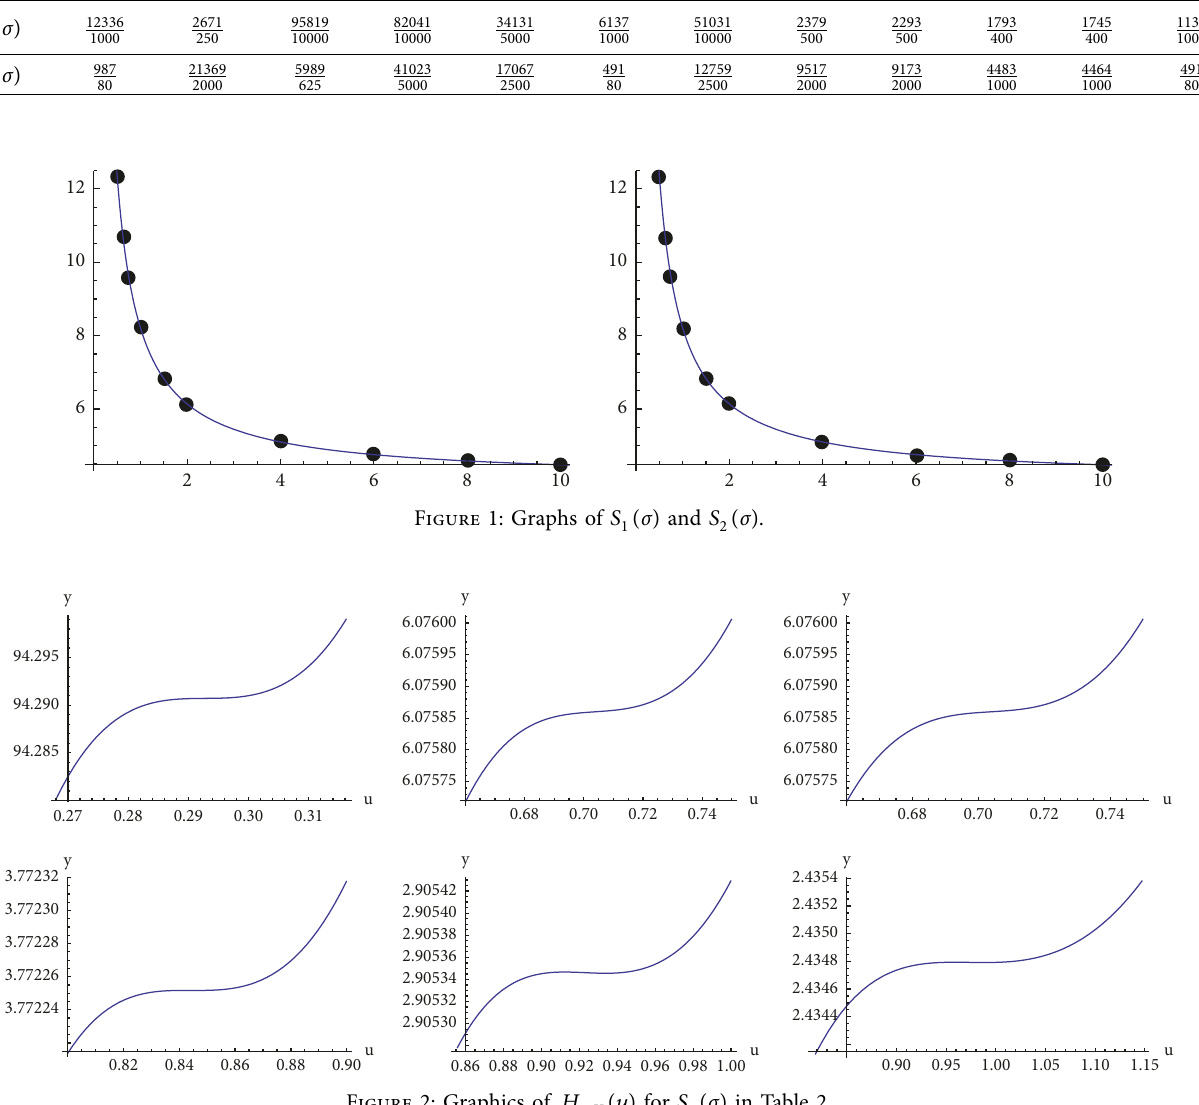
( u ) for S ( σ ) in Table 2. σ ,K 1